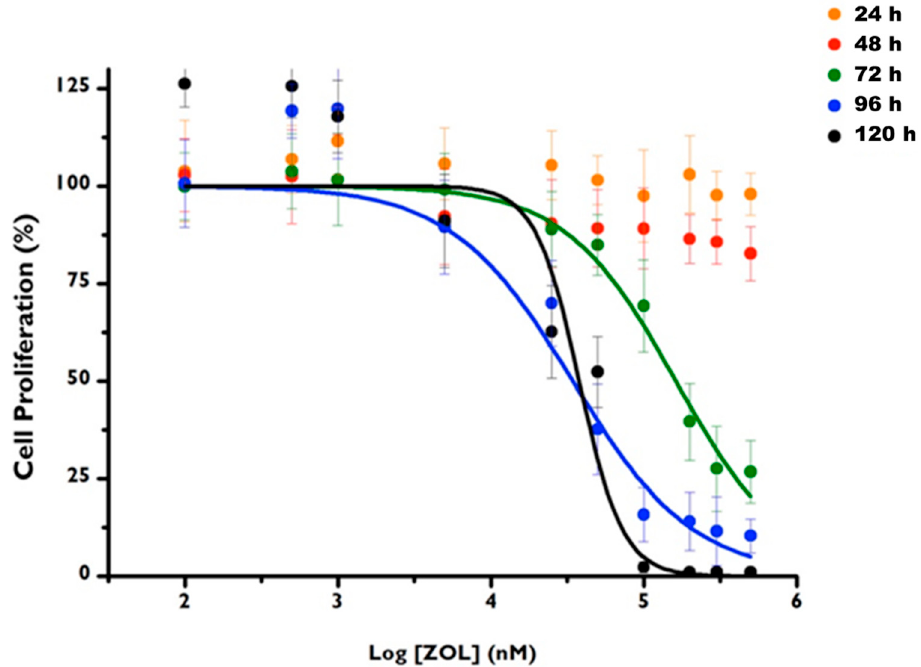
Figure 3. Dose-response curves of HGF primary cell cultures after 24 h, 48 h, 72 h, 96 h and 120 h of incubation with ZOL in concentrations ranging from 0.1 to 1 mM. The bars represent the mean and standard deviation of at least six tests.